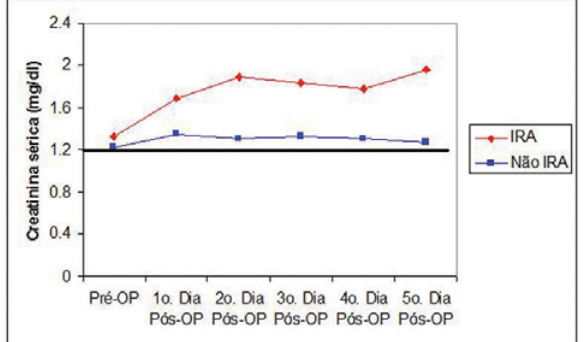
Fig. 1 - Média da creatinina sérica no pré-operatório (Pré-op) e pós-operatório (Pós-op) do 1 o ao 5 o dia, segundo a presença ou não de insuficiência renal (IRA), Hospital Universitário / UFMS,